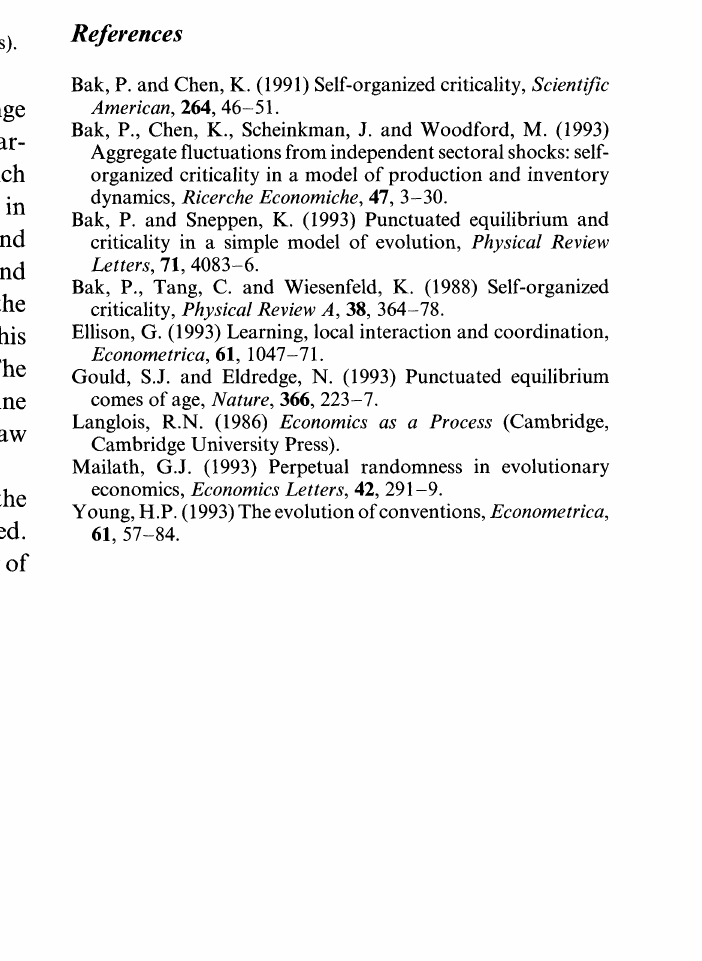
FIGURE 4 Distribution of strategy changes (after 10 100 runs with 64 players).